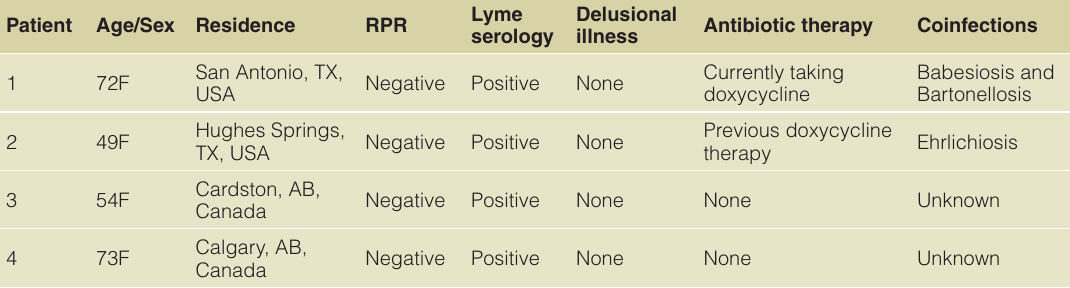
Table 1. Summary of Morgellons disease patient